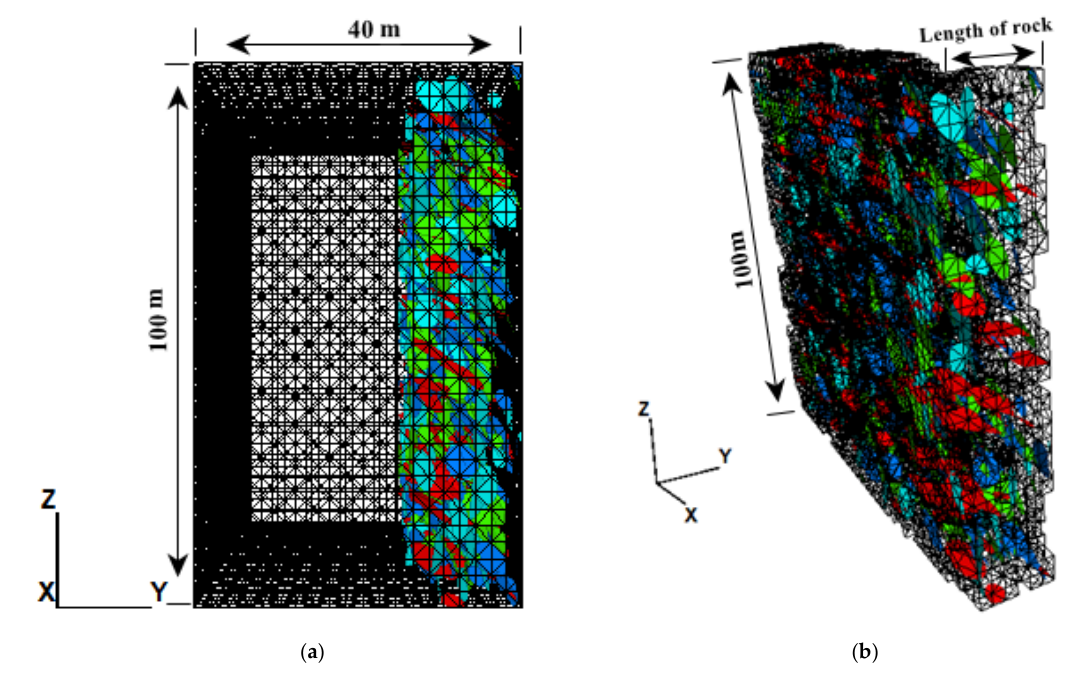
Figure 13. Comparison of theoretical and measured values. ( a ) Comparison of theoretical and measured water inflow under different permeability coefficients; ( b ) Ratio of different theoretical water inflow to measured values. Where 3 stand for ZDDK365+333 to +313, 4 stand for ZDDK365+323 to +313, 5 stand for PDK365+313 to +308 (L), 6 stand for PDK365+316 to +308 (L), 7 stand for PDK365+319 to +308 (L), 8 stand for PDK365+322~+308 (L), 9 stand for PDK365+325 to +308 (L), 10 stand for YPDK365+315.5 to +312.5 (L), 11 stand for YPDK365+317.5 to +312.5 (L), 12 stand for ZDDK365+307.5 to +292.5 (L), 13 stand for ZDDK365+310.5 to +292.5 (L), 14 stand for ZDDK365+290 to +275, and 15 stand for ZDDK365+293 to +275.